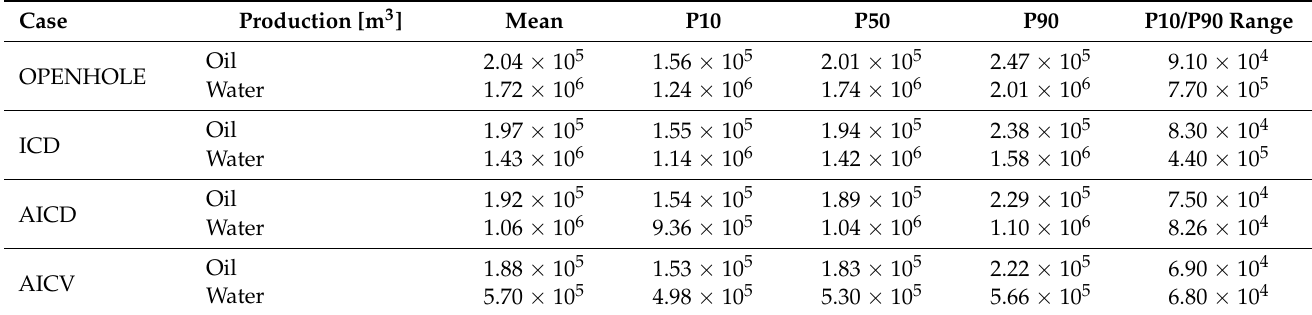
Table 4. Summary of the obtained results from the uncertainty quantification.